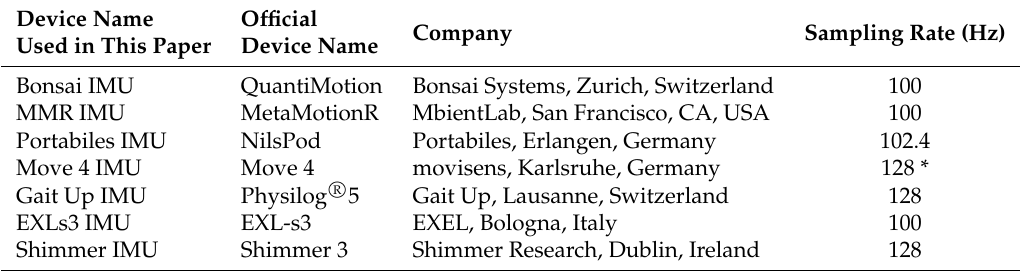
Table 4. IMU devices tested in this